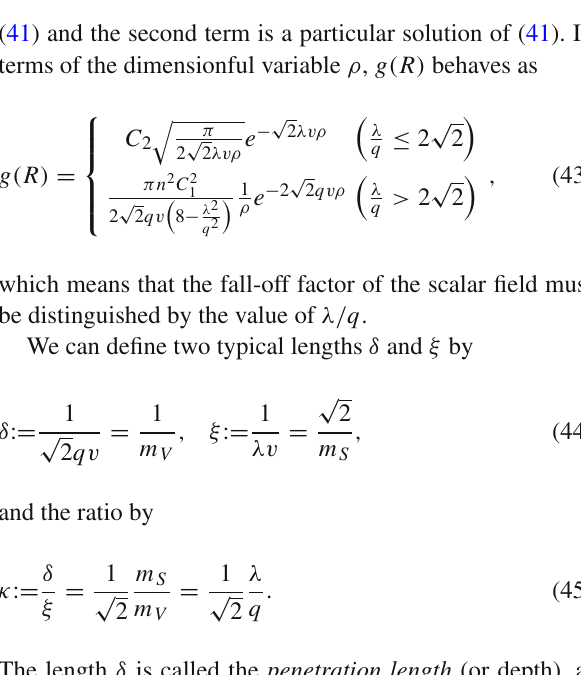
Fig. 6 The penetration and coherent lengths: (Left panel) the type I superconductor with κ = 1 κ =